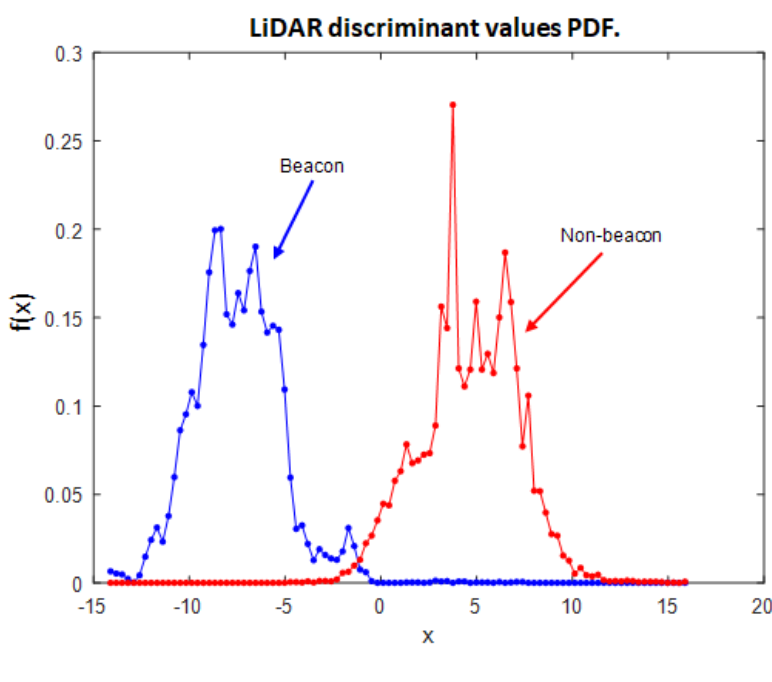
Figure 15. LiDAR discriminant